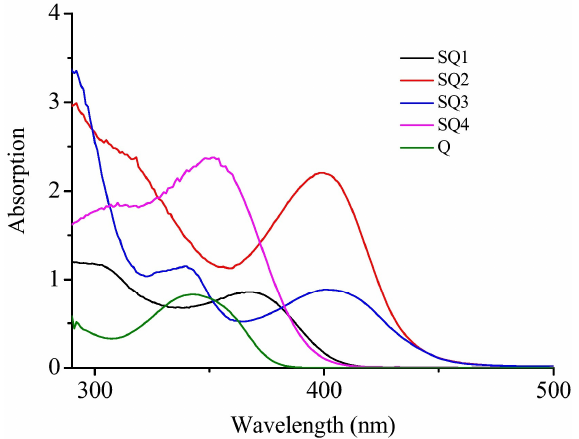
Figure 32. UV-visible absorption spectra of SQ1–SQ4 in chloroform. Reprinted from Ref. [244] , Copyright 2017, Elsevier. Table 12. Optical characteristics of SQ1–SQ4 in chloroform.